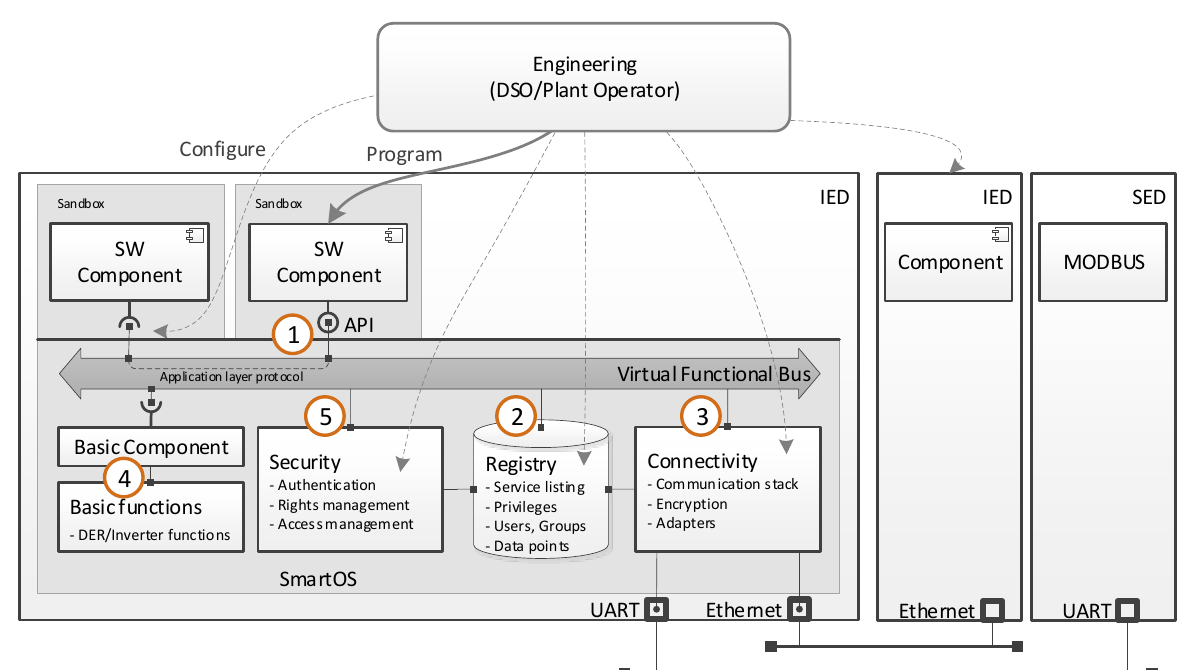
Figure 6. SmartOS and Virtual Functional Bus (VFB) (adopted from Reference